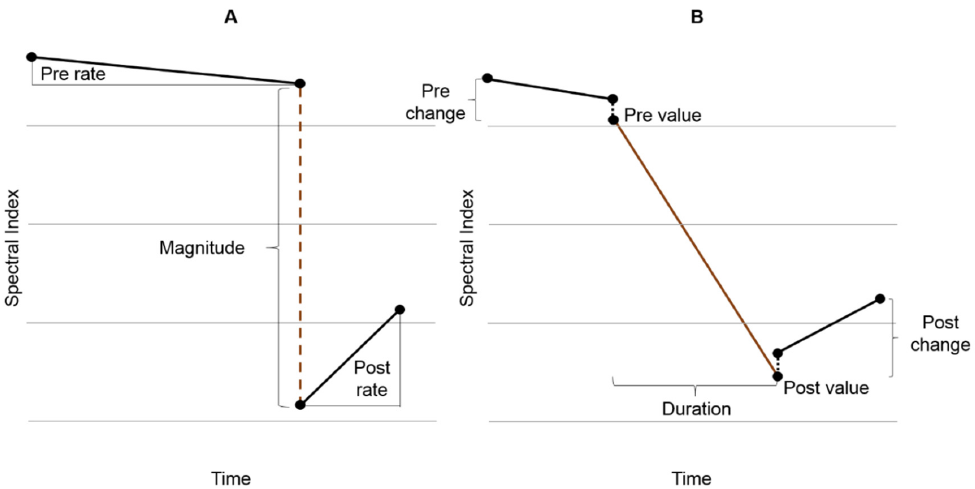
Figure 3. Schematic illustration of metric extraction from linear model segments with the greatest disturbances highlighted in red. Two cases are shown: ( A ) an abrupt disturbance process detected as a breakpoint and ( B ) a gradual disturbance detected as a linear segment.